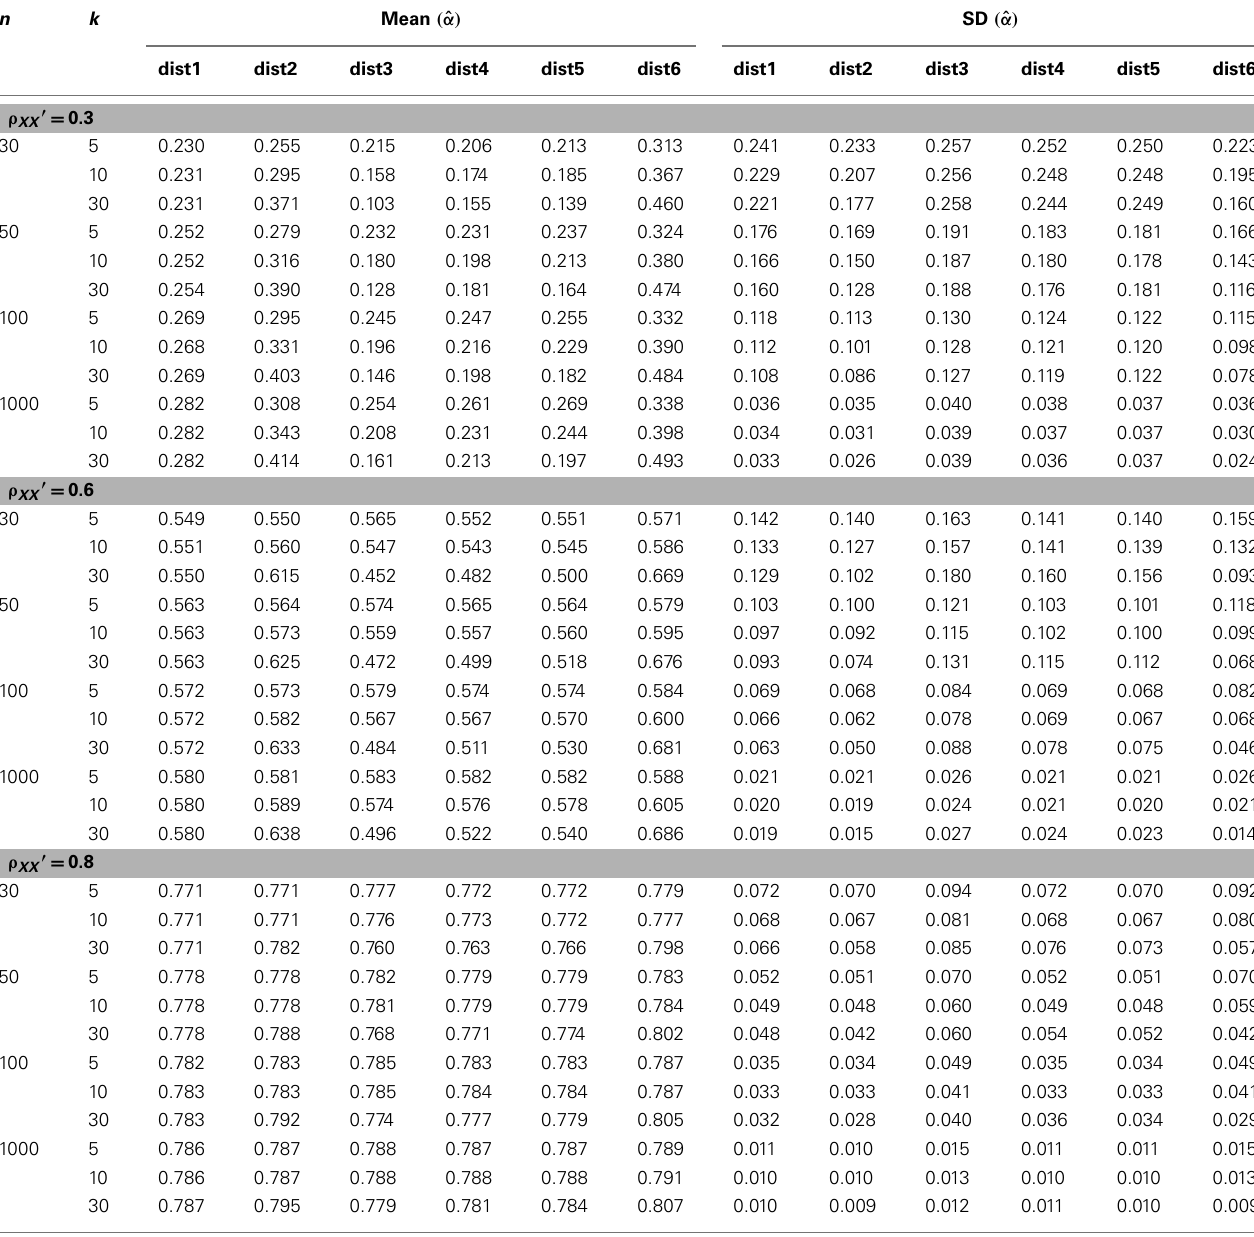
Table 4 | Observed mean and SD of the sample alpha ( ˆ α ) for the simulated situations where the error score ( e ij ) distribution is normal or non −